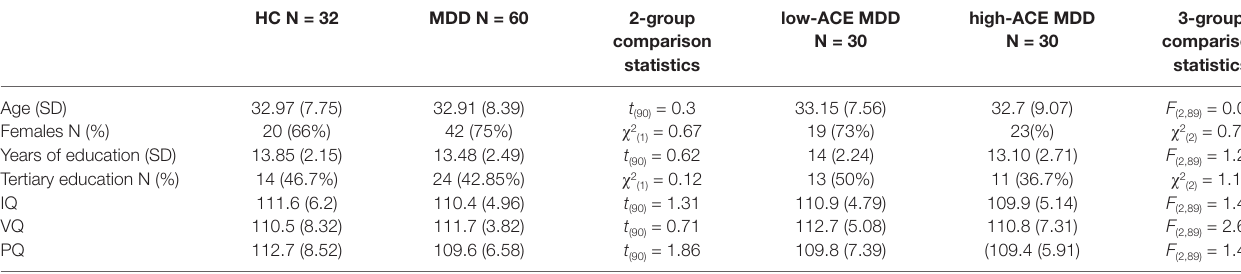
TABle 1 | Demographic and IQ data of the sample: there were no significant between-group differences.